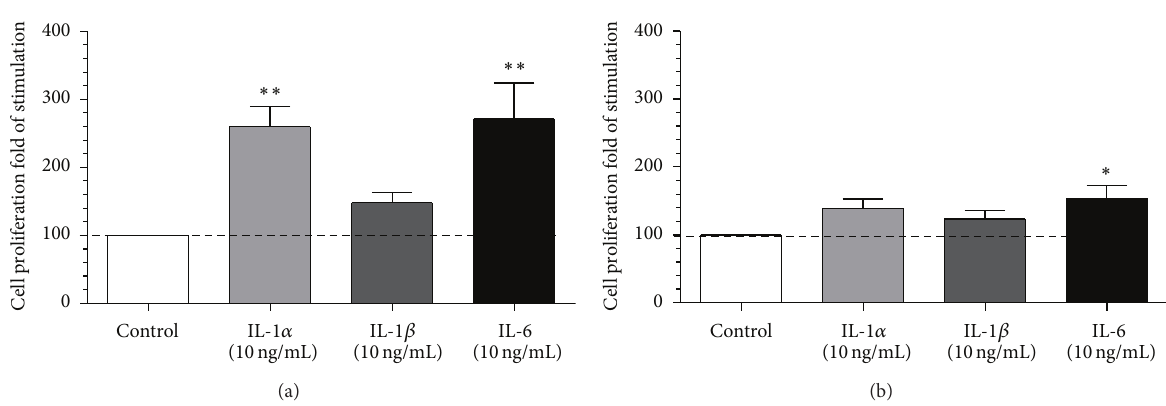
Figure 2: The effect of IL-1 𝛼 (10ng/mL), IL-1 𝛽 (10ng/mL), or IL-6 (10ng/mL) on proliferation of (a) epithelial cells (mean ± SEM; 𝑛 = 5 ) and (b) stromal cells (mean ± SEM; 𝑛 = 5 ) after 24h incubation. All values are expressed as n- fold change from control. Asterisks indicate significant differences ( ∗ 𝑃 < 0.05 ; ∗∗ 𝑃 < 0.01 ) from the respective control, as determined by parametric one-way ANOVA followed by Newmann-Keuls comparison test.